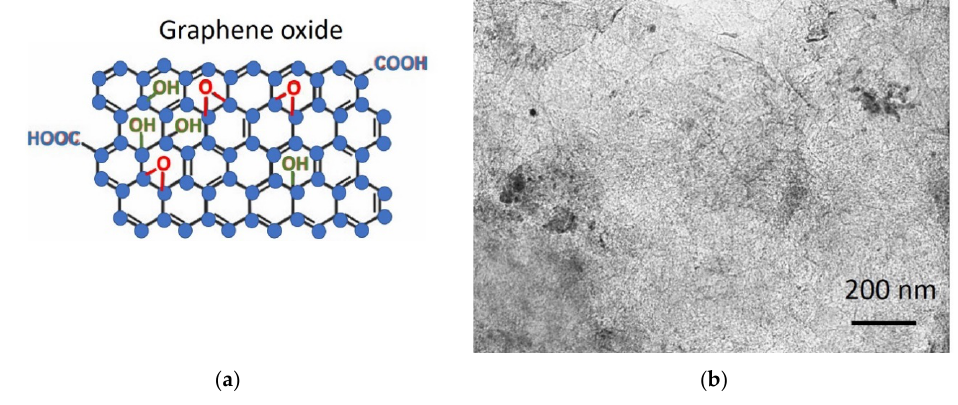
Figure 2. Structure of graphene oxide. ( a ) Schematic view, ( b ) TEM image.